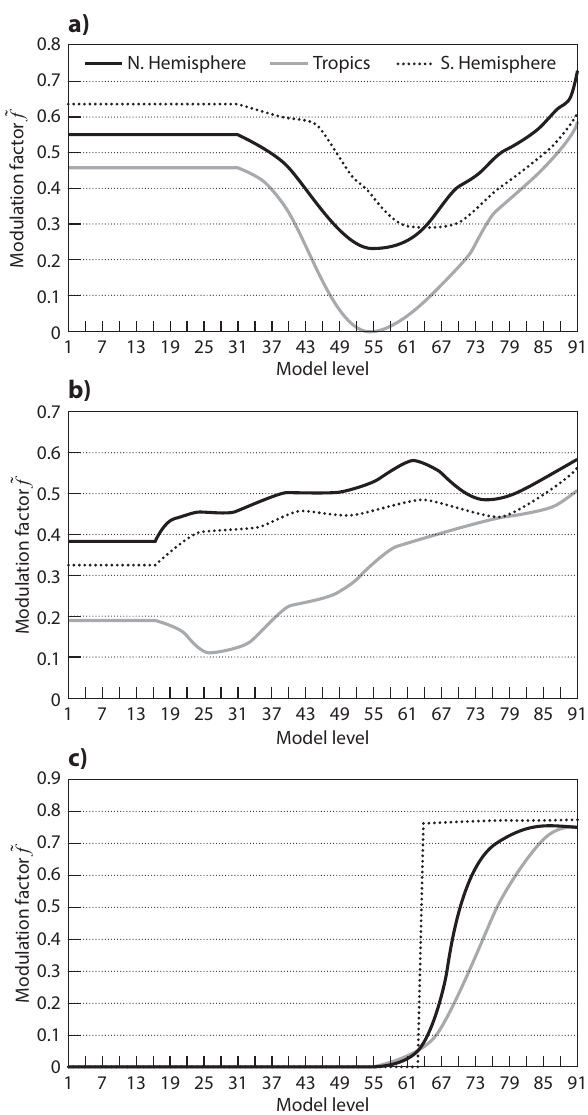
Figure 1. Perturbation modulation factor ˜ f as a function of lat- itude band (North Hemisphere solid black line, Southern Hemi- sphere dotted line, and tropics solid grey line) and vertical model levels (model level 1 is 0.01hPa and 91 is on average ∼ 1000hPa) for (a) zonal wind, (b) temperature, and (c) humidity. The modula- tion factor is estimated over a 3-week period.